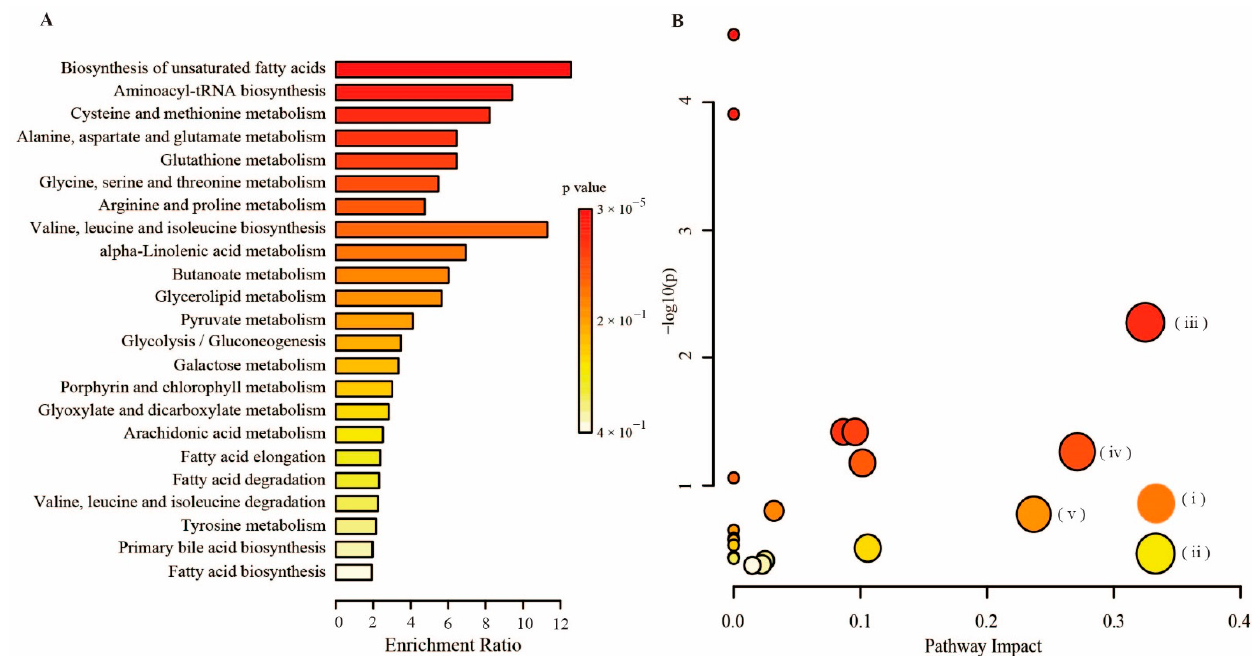
Figure 10. Summary of pathway analysis with MetaboAnalyst. ( A ) Enrichment analysis performed using the pathway-associated metabolites sets with MetaboAnalyst 4.0. ( B ) Overview of pathway analysis using Fisher’s Exact Test as algorithms with MetaboAnalyst 4.0; (i) alpha-linolenic acid metabolism, (ii) arachidonic acid metabolism, (iii) cysteine and methionine metabolism, (iv) glycine, serine and threonine metabolism, (v) glycerolipid metabolism.